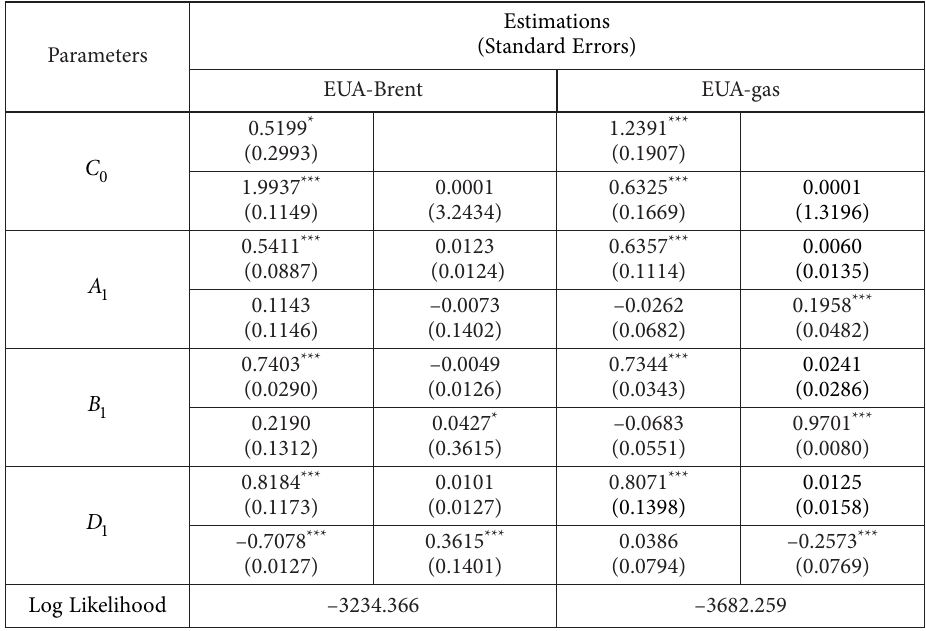
Table 3. Estimation of asymmetric BEKK (1, 1) Model to the Daily Log Returns of EUA and Brent, Natural gas from 22/4/2005 to 17/12/2007 for 661